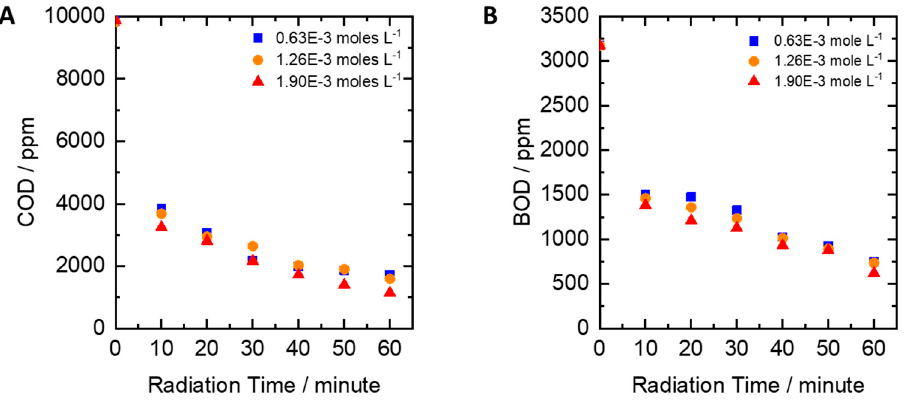
Figure 6. ( A ) COD and ( B ) BOD degradation of textile wastewater with concentration of iron (III) oxide catalyst variation. Conditions: pH 6, 0.61 moles / L concentration of H 2 O 2 , and 30-watt lamp power.